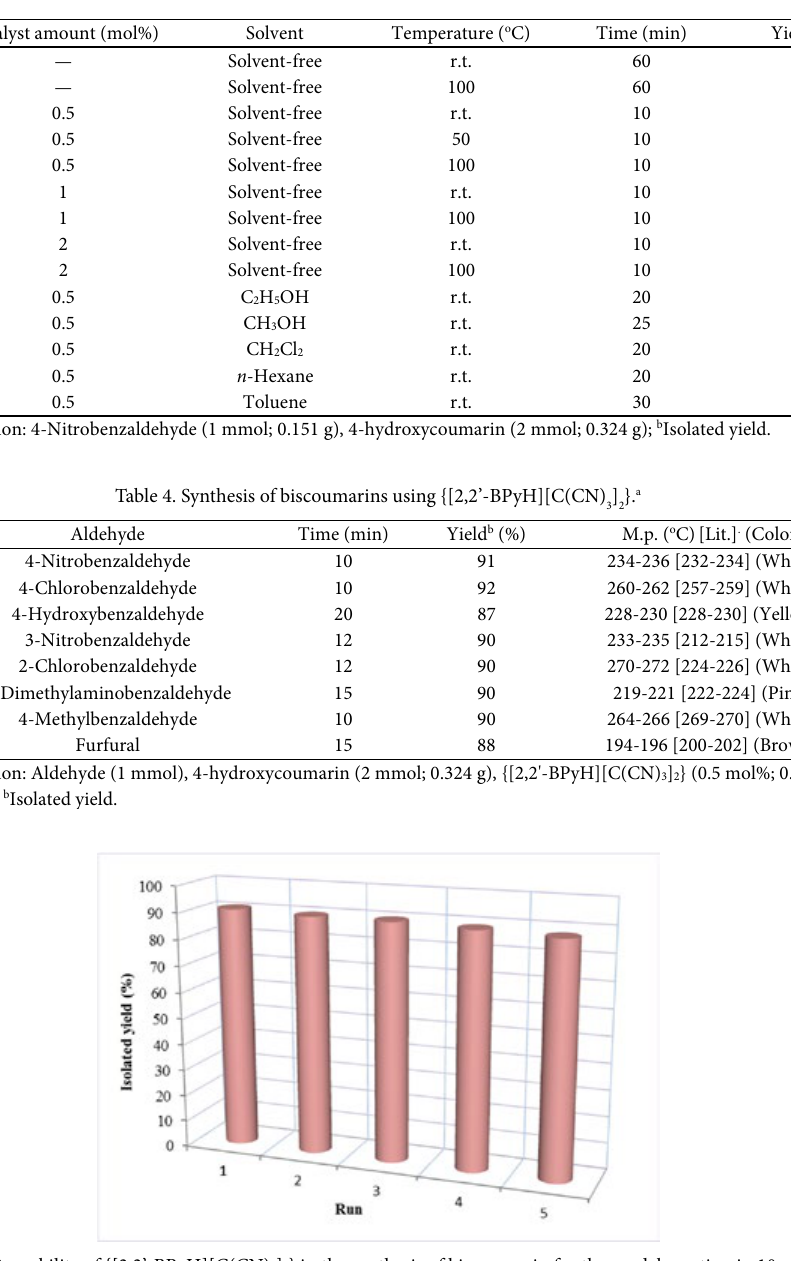
Table 3. Optimizing the reaction condition in the synthesis of biscoumarins. a